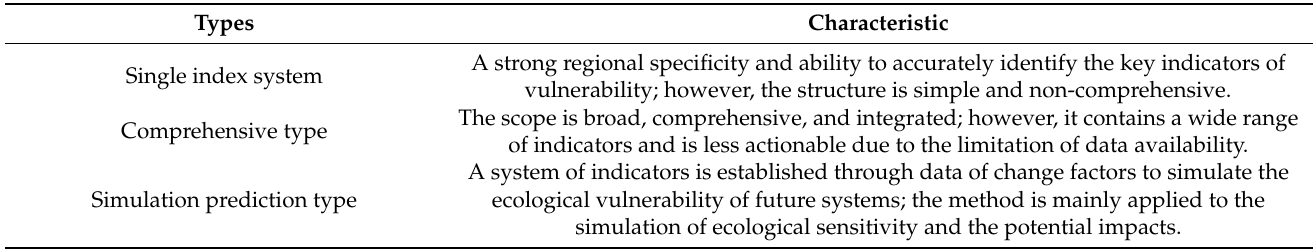
Table 1. Types of ecological vulnerability assessment index systems.